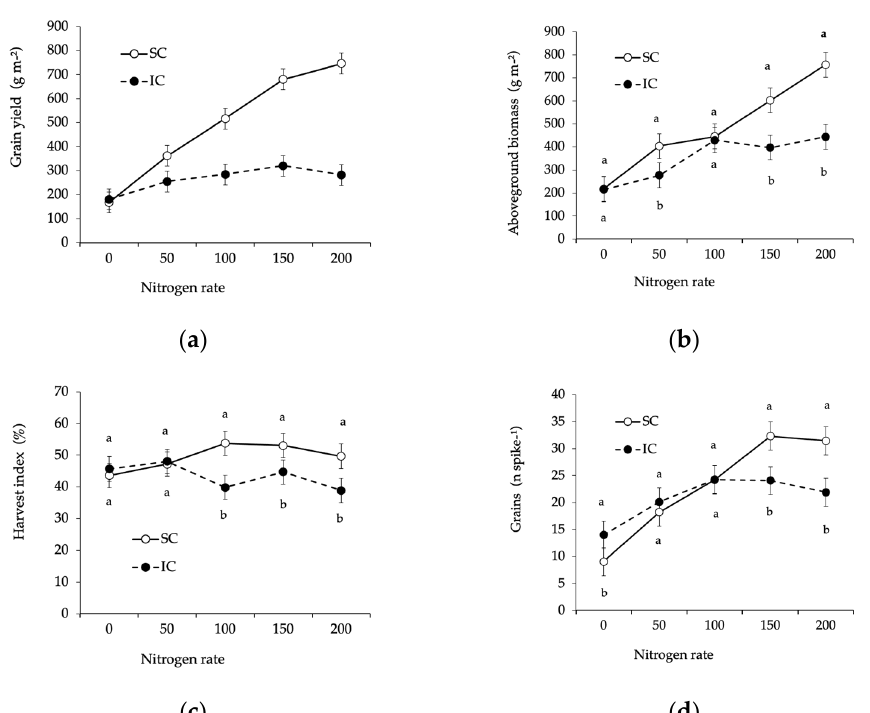
Figure 6. Cropping system × nitrogen rate interaction effect on ( a ) grain yield, ( b ) aboveground biomass, ( c ) harvest index, and ( d ) grains per spike of barley. Values are means of two years, five N rates, and three replicates. Vertical lines represent HSD and values with the same letter are not statistically different for p ≤ 0.05. SC = sole crop; IC = intercrop. Higher grain yield of barley sole crop was mainly due to a higher number of spikes produced per unit area (+38%) but also to heavier kernels (+17%) (Table 3) and, with the higher N rates, to higher number of grains per spike ( d ). With increasing N rates, the grain yield of barley significantly increased in both cropping systems, but the rise was drastically higher (+260%) in barley sole crop than in the IC (+56%), and at the highest N rate it was 4.6-fold higher in SC than in IC (Figure 6a). A similar behavior was registered in the aboveground biomass assessed at maturity, even if differences due to N rates were less marked than for grain. Up to N100, biomass was almost similar between SC and IC, while it was +111% and +165% higher in SC with 150 and 200 kg N ha − 1 (Figure